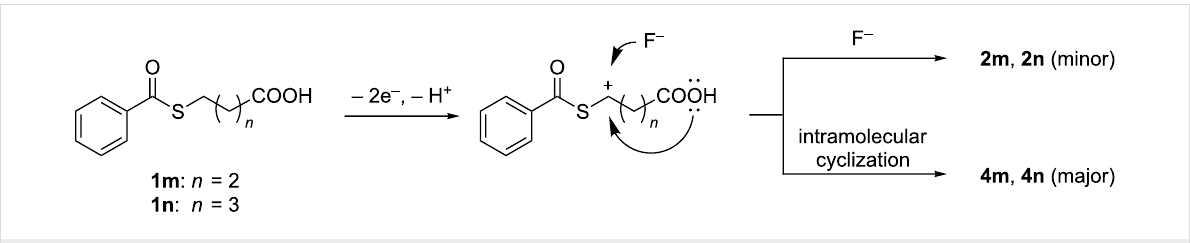
Scheme 6: Reaction mechanism for the anodic oxidation of carboxylic acids 1m and 1n in the presence of a fluoride source.